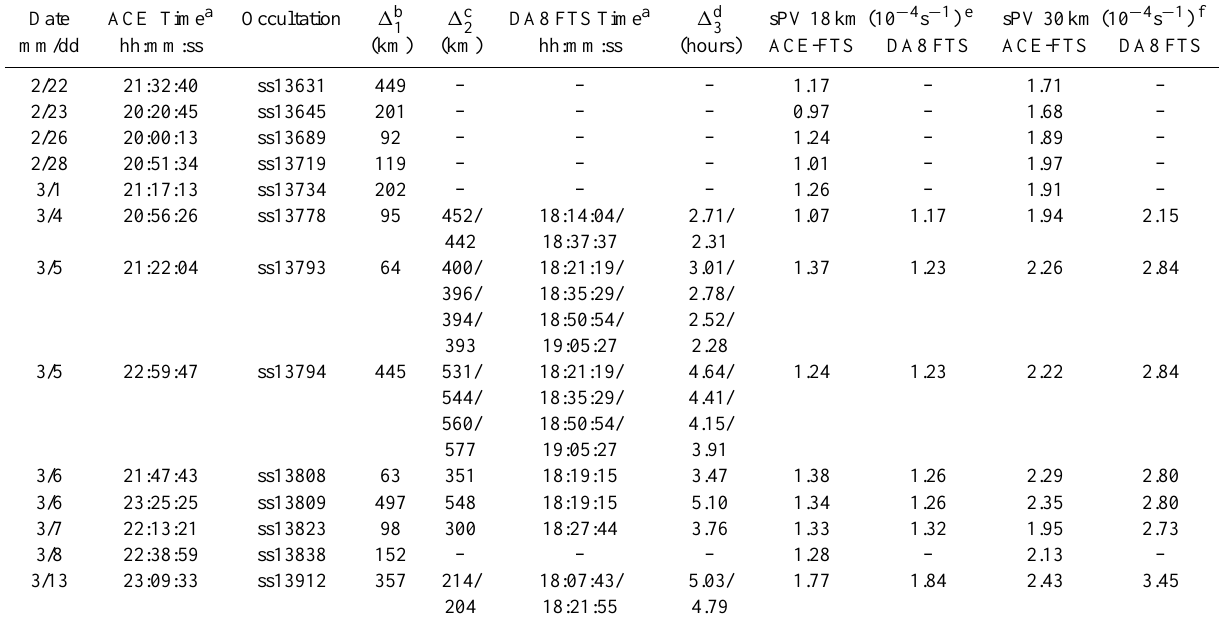
Table 10. The spatial and temporal differences between DA8 and ACE-FTS for NO during the 2006 Canadian Arctic ACE Validation